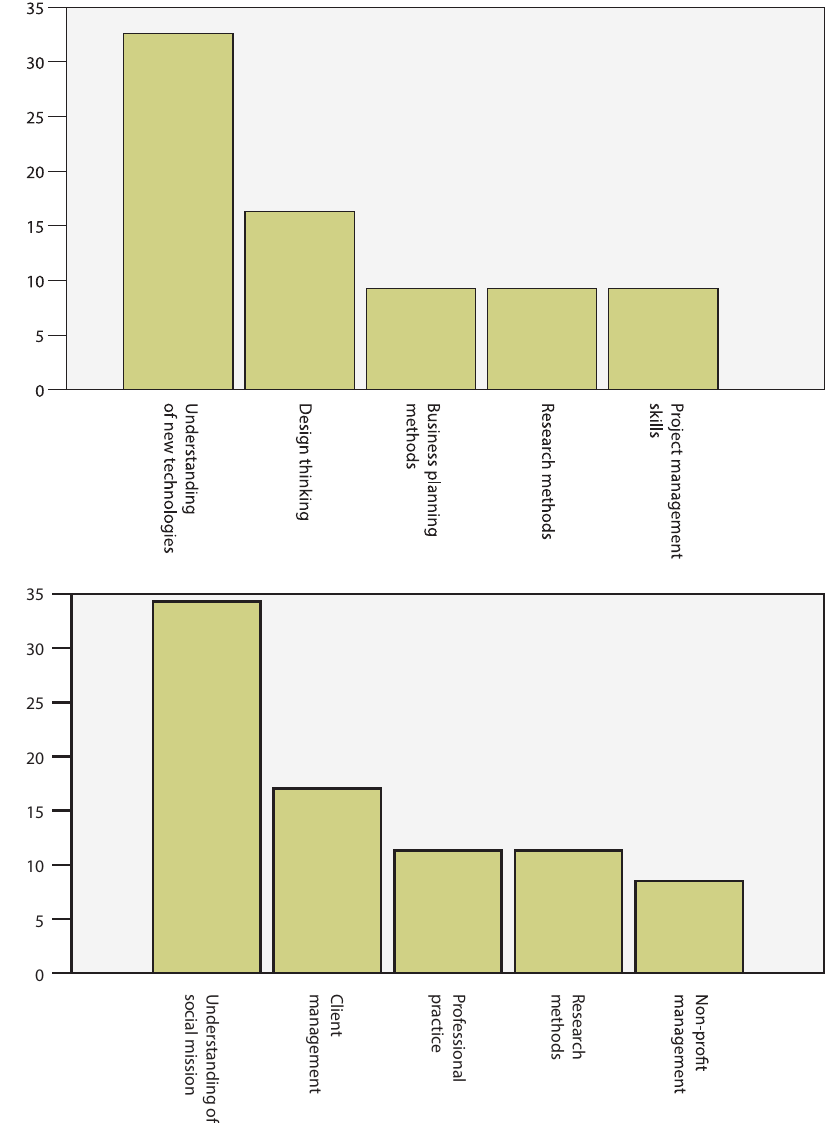
Figure 3: Top five responses